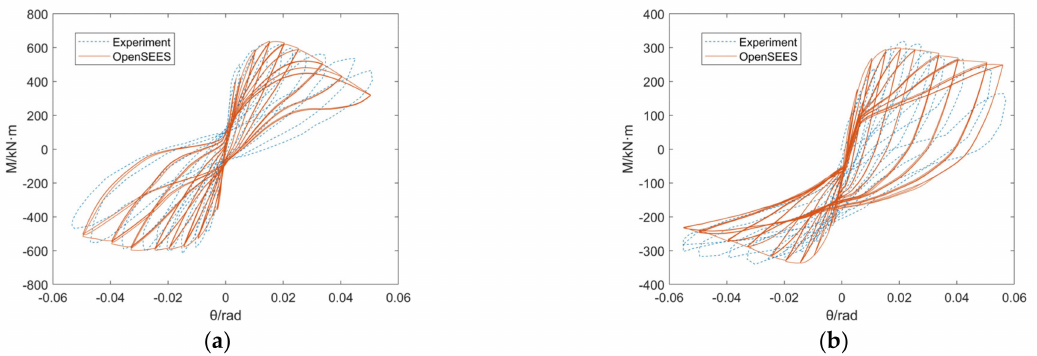
Figure 8. Simulated hysteresis curves of specimens in [28]: ( a ) simulated hysteresis curve of A2 specimen; ( b ) simulated hysteresis curve of B2 specimen.